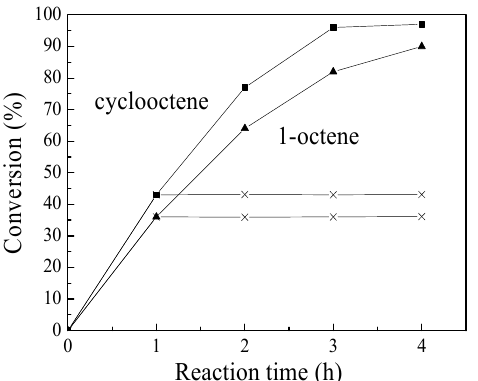
Figure 5. Kinetic profiles of the epoxidation of cyclooctene and 1-octene over the catalyst 1 . ( ⅹ ) Leaching experiments of the catalyst indicating conversion of cyclooctene and 1-octene with the catalyst removed after 4h at reaction temperature. Reaction conditions: catalyst 10 mg, substrate 1.0 mmol, CH 3 CN 10 ml, flow of air 10 ml/min, IBA 2.0 mmol, reaction temperature 40 ℃ . All selectivities for the epoxide are ≥ 99%.